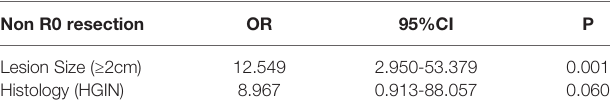
TABLE 4 | Multivariate logistic regression of ef fi cacy